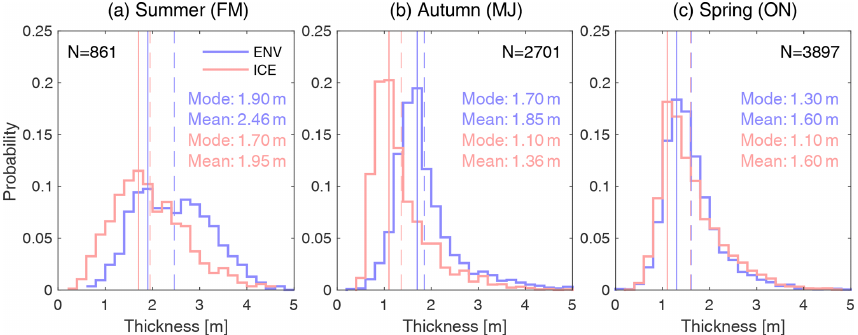
Figure 7. Probability of the Envisat SIT and the ICESat SIT for all the individual comparison pairs. The blue stairs represent Envisat ice thickness, and the red stairs represent ICESat ice thickness. The solid lines indicate the modal ice thickness, and the dashed lines indicate the mean ice thickness of both data sets. The bin size is 0.2m, and the probability distribution is normalized.